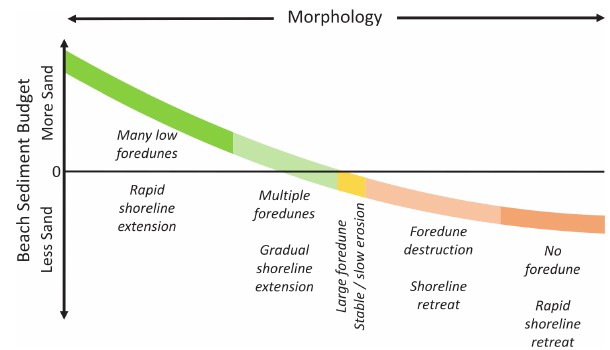
Figure 1. Conceptual morphological continuum, depicting the sub- aerial characteristics of a barrier in response change in beach sed- iment budget. Modified from Psuty (2008). Used with permission from Springer